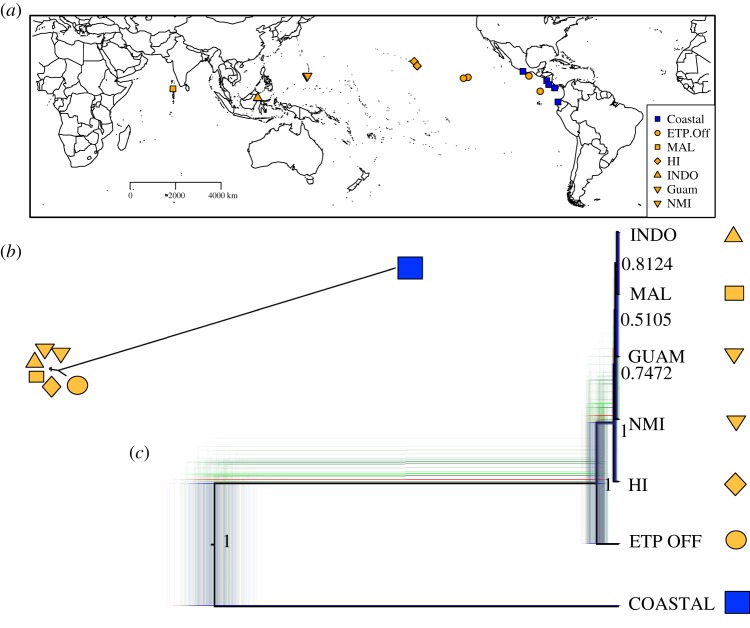
Bayesian species tree for spotted dolphins 3524 SNPs. (a) A map representing the sampling localities for the reduced sample set used (n = 22) to decrease computation time for phylogeographic analysis (see electronic supplementary material, table S2). (b) The unrooted tree MCC tree. The coastal subspecies (S. a. graffmani) is labelled with a blue box, while all other pantropical (S. a. attenuata) are labelled in orange. Offshore eastern tropical Pacific spotted dolphins are represented by an orange circle (ETP OFF); Hawai‘i is represented by an orange diamond (HI); Northern Marianas Islands (NMI) and Guam are represented by inverted triangles; Maldives (MAL) is labelled with a square and Indonesia (INDO) is labelled with a standard triangle. (c) In black is the mid-point rooted MCC tree. It is overlaid onto all trees, coloured as in figure 5.